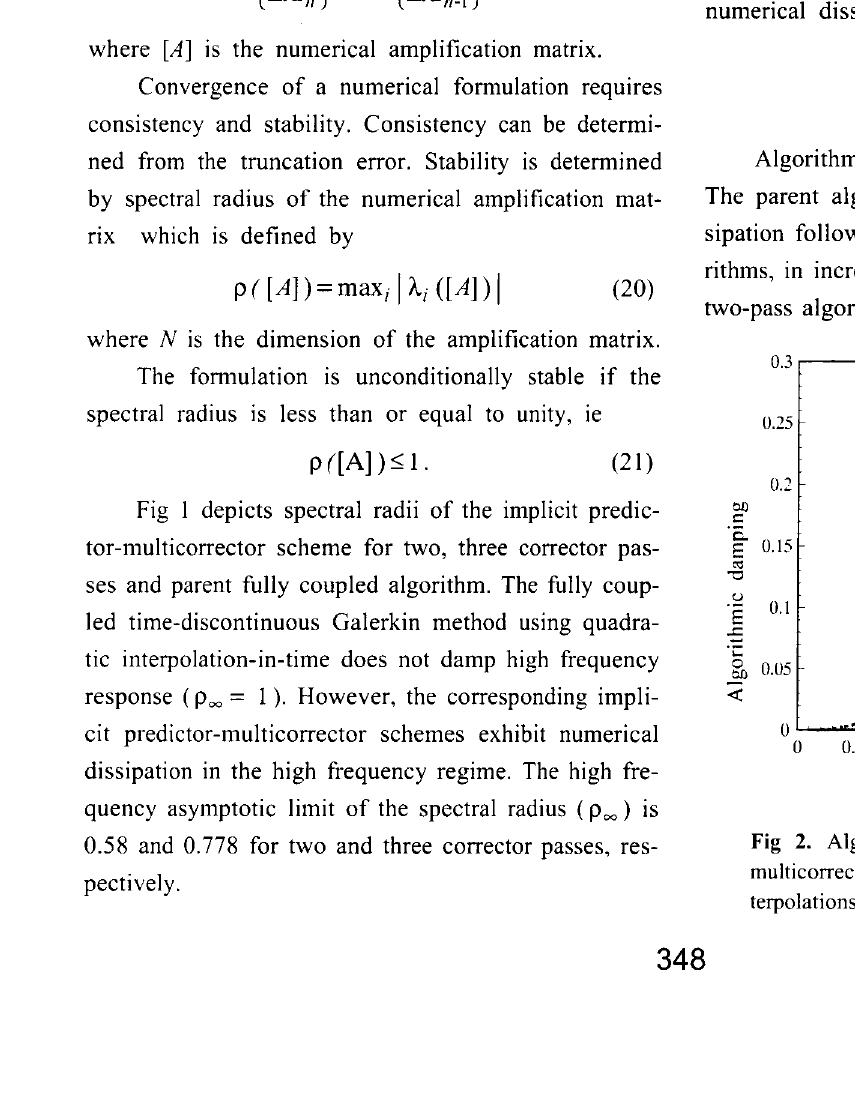
Fig 1. Spectral radii for the predictor-multicorrector al gorithms based on quadratic-in-time interpolations for the time-discontinuous Galerkin method When solving dynamical problems it is common procedure to separate the error in numerical schemes, into dissipation, namely, amplitude error, and disper sion, namely, phase error. Provided that the eigenvalu es of [A] remain complex ('Au([A])=A±iB,B:;tO), algorithmic damping ratio provides a measure of the